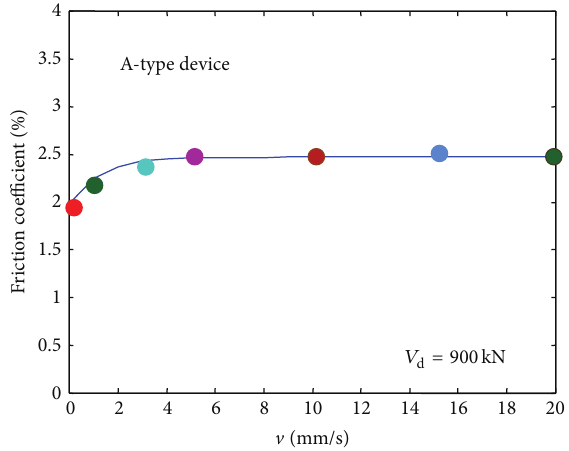
Figure 9: Friction coefficient values as a function of V —A-type = 900 isolator, 𝑉 d